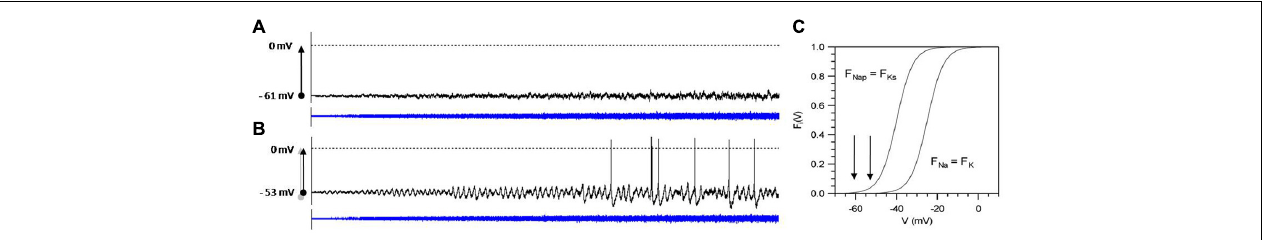
FIGURE 5 | Computer simulation of noise effects on a model neuron of subthreshold oscillations and spike generation, tuned to different steady-state potentials ( A: –61 mV, B: –53 mV) and subjected to noise of increasing intensity D ( D = 0 to 0.4, blue curves) Simulation time: 10 s. Arrows in (C) indicate the position of the steady-state potentials in comparison to the activation curves F ( V ) of the subthreshold currents ( F Nap , F Ks ) and spike generating currents ( F Na , F K ). Model equations and parameter values are given in Huber and Braun (2006).